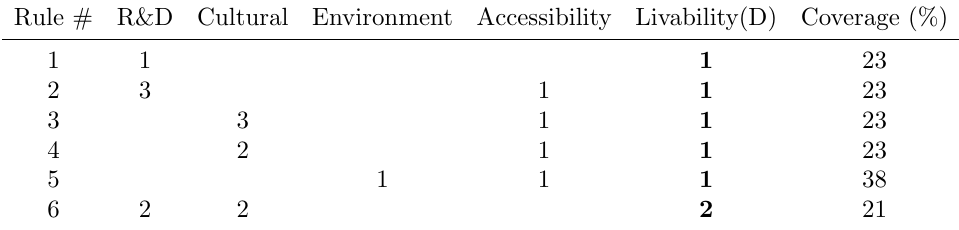
Table 5: Rough set rules explaining XXQ Livability by composite factors using 3 classes Rule # R&D Cultural Environment Accessibility Livability(D) Coverage